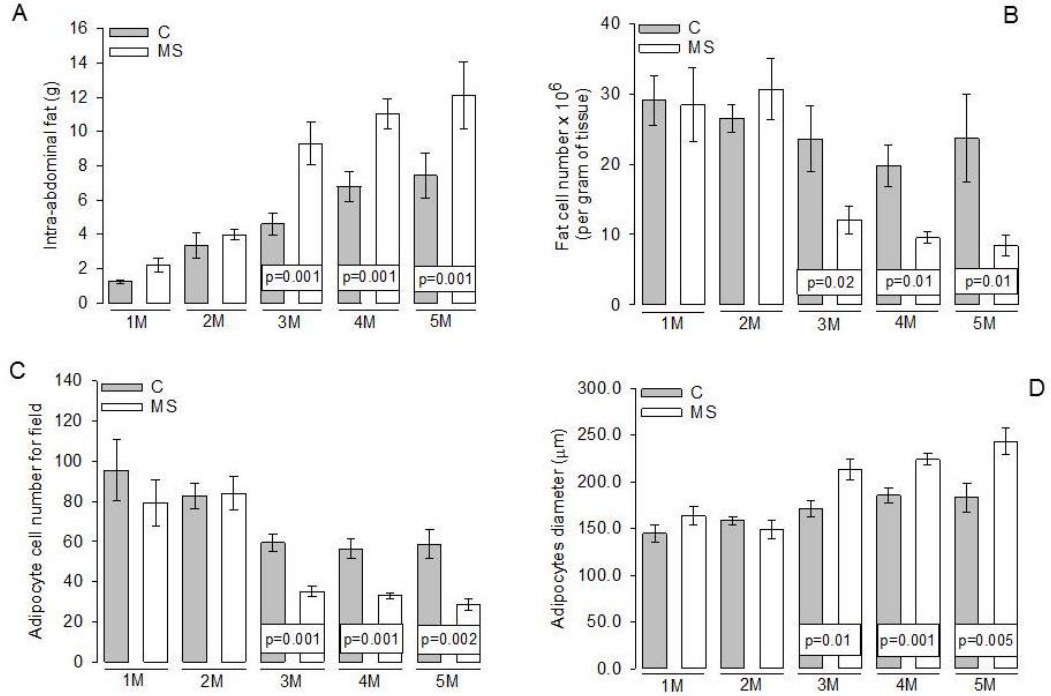
Figure 1. Representative histograms: ( A ) intra-abdominal fat. ( B ) Fat cell number per gram of tissue. ( C ) Adipocyte cell number for field and ( D ) adipocyte diameter. Data show the mean ± SEM; n = 7 rats per experimental group. Abbreviations: C = Control; MS = Metabolic syndrome; M = Month.